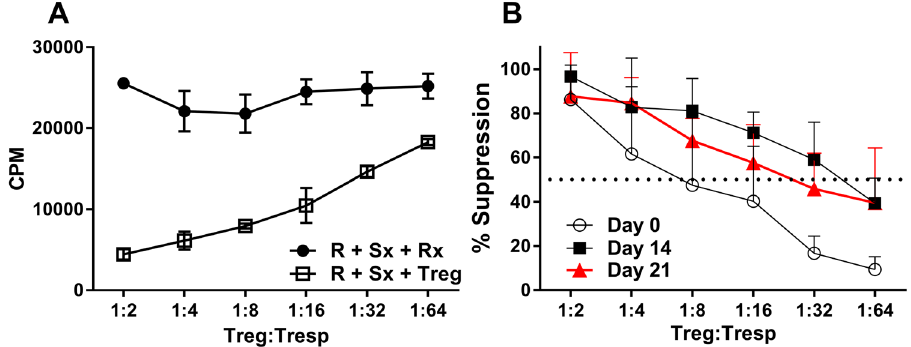
Figure 3. In process testing of Tregs suppressive function: Suppression assays were performed. (R) denotes recipient PBMC’s; (Sx) denotes irradiated healthy allogeneic PBMC’s (stimulators); (Rx) denotes irradiated responder cells used as a control to keep cell number consistent across groups. ( A ) Graph shows raw count per minutes ( ± SD in triplicate cultures) of thymidine incorporation assay after six days of culture (representative). ( B ) Average ( ± SD) of percent suppression (n = 9) at varying Treg: Tresp ratios throughout clinical expansion protocol. Percent suppression calculated as described in materials and